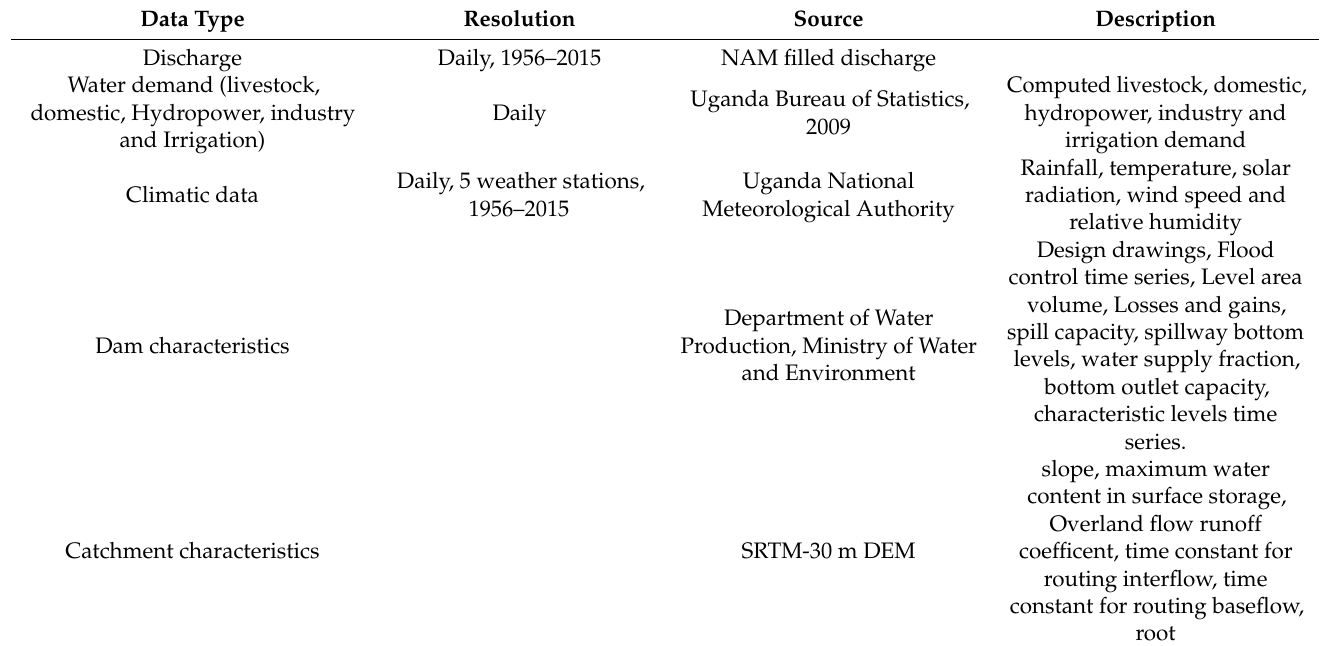
Table 2. Mike Hydro input